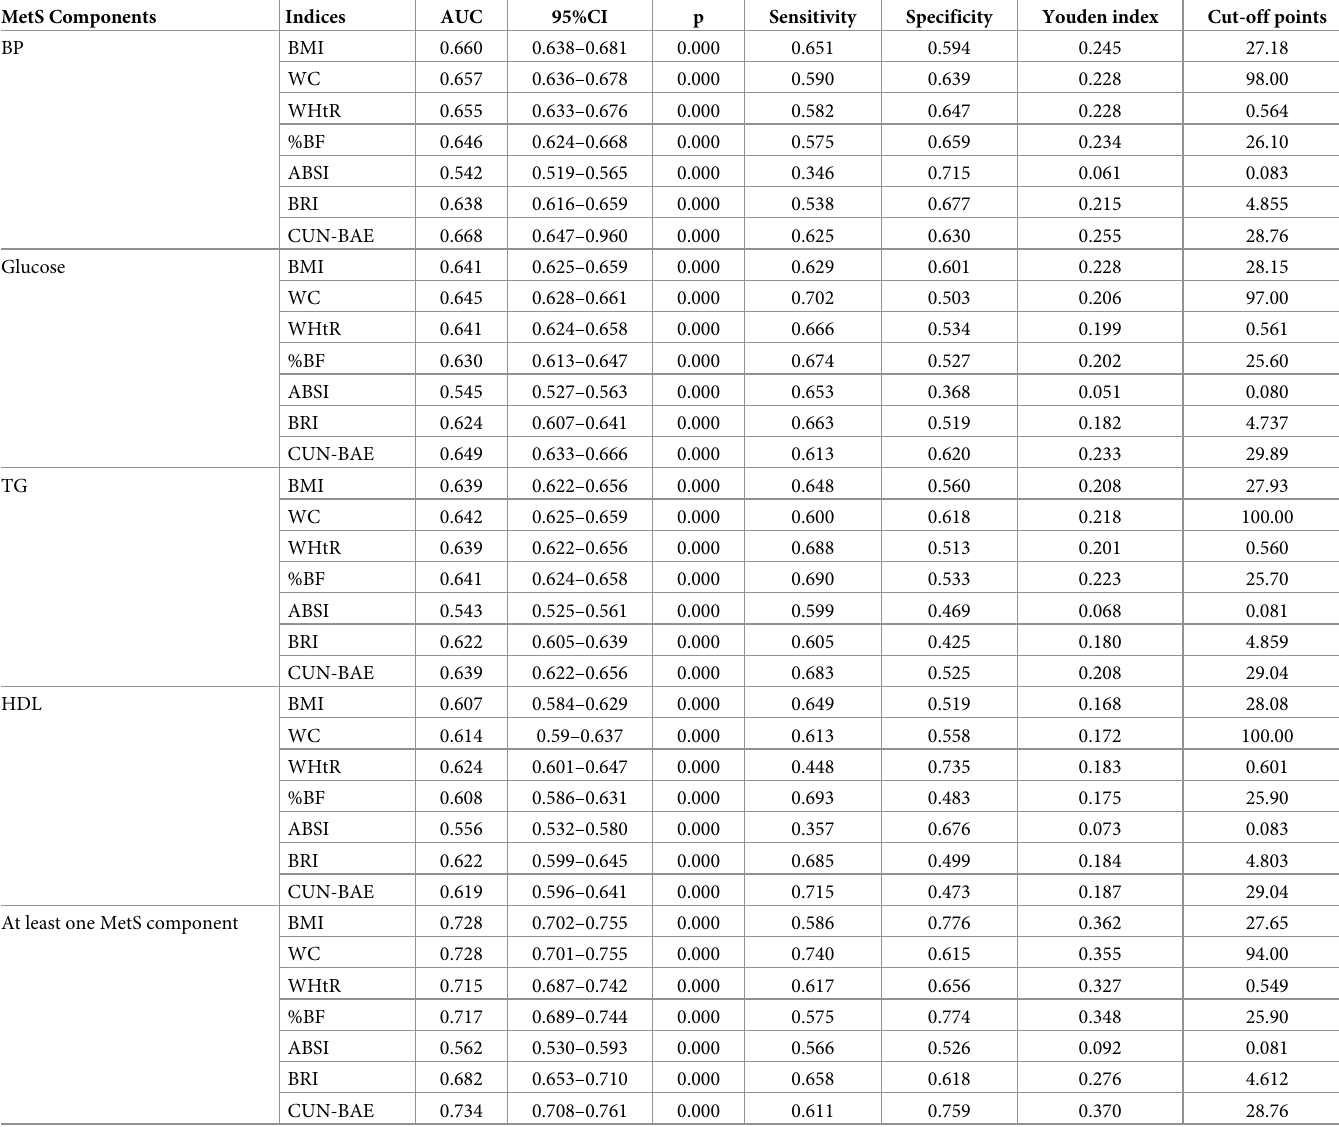
Table 3. Areas under the curve (AUCs) and cut-off points for anthropometric indices for the prediction of MetS components in men. MetS Components